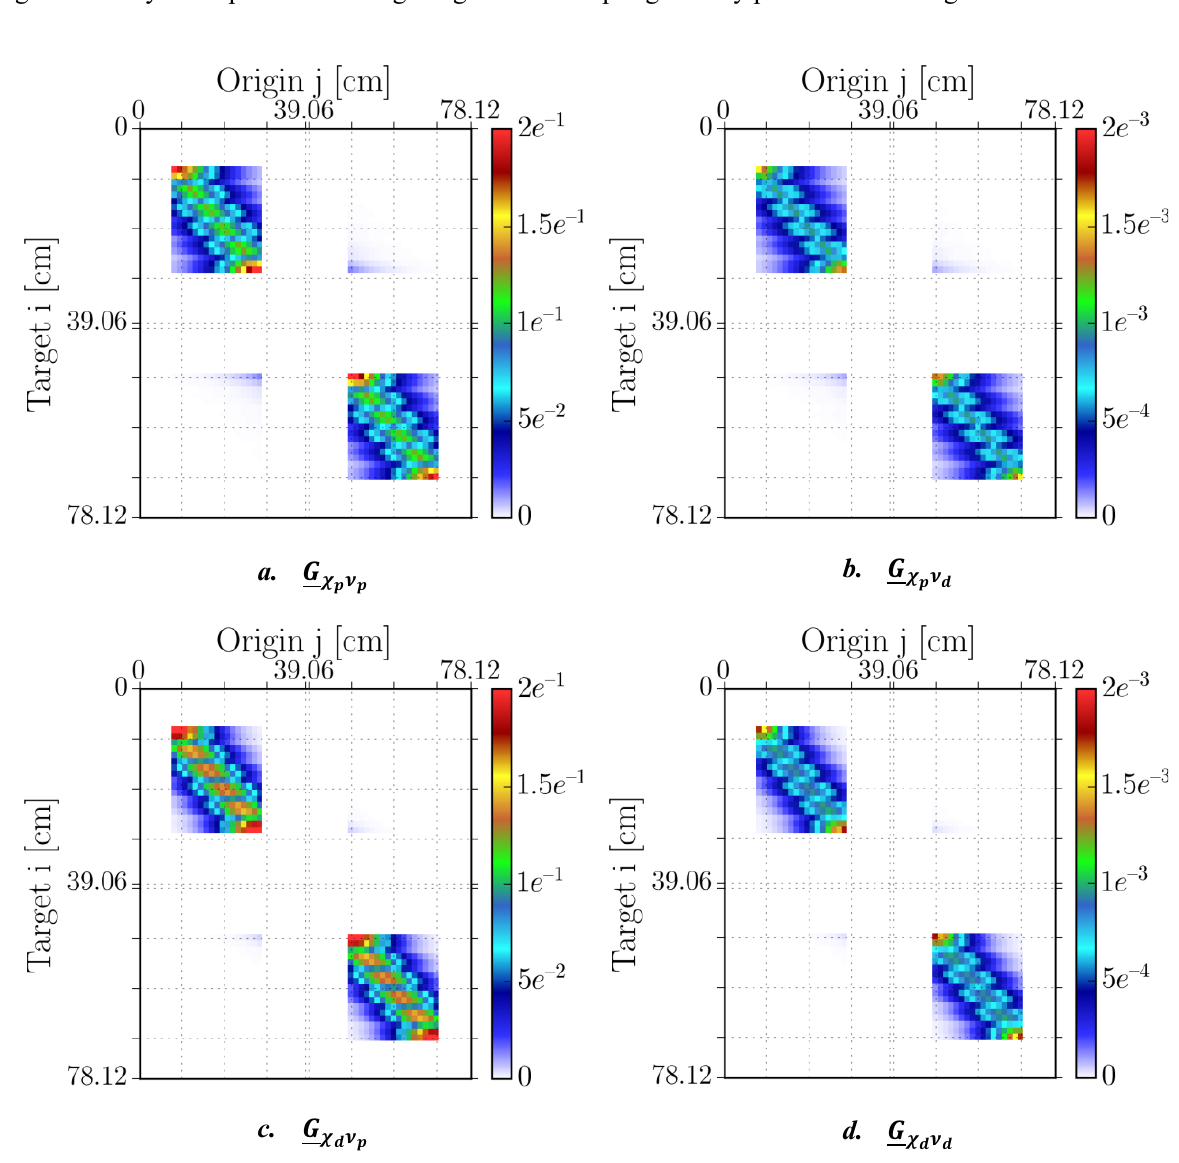
Figure 3. M matrices for the UOX – UOX geometry, for a 20.16 cm (16 x pitch) water blade width. The color scale expresses the propagation